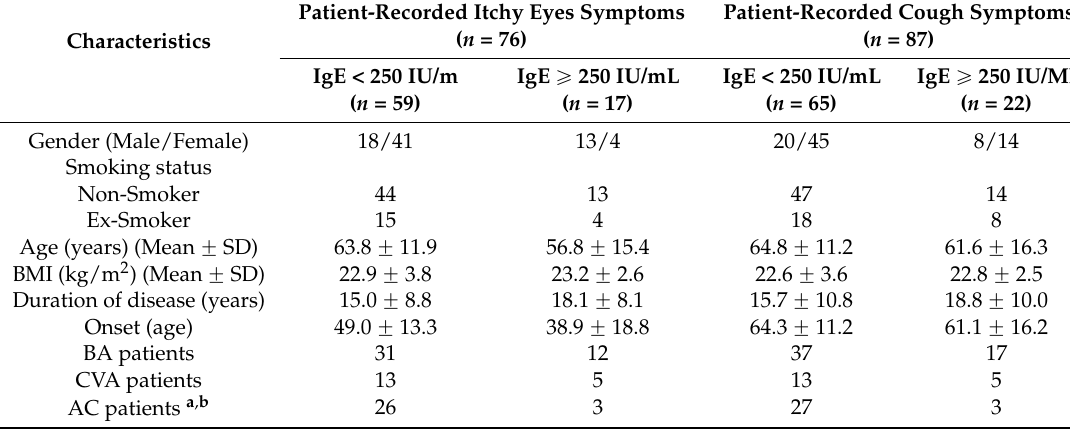
Table 1. Characteristics of the